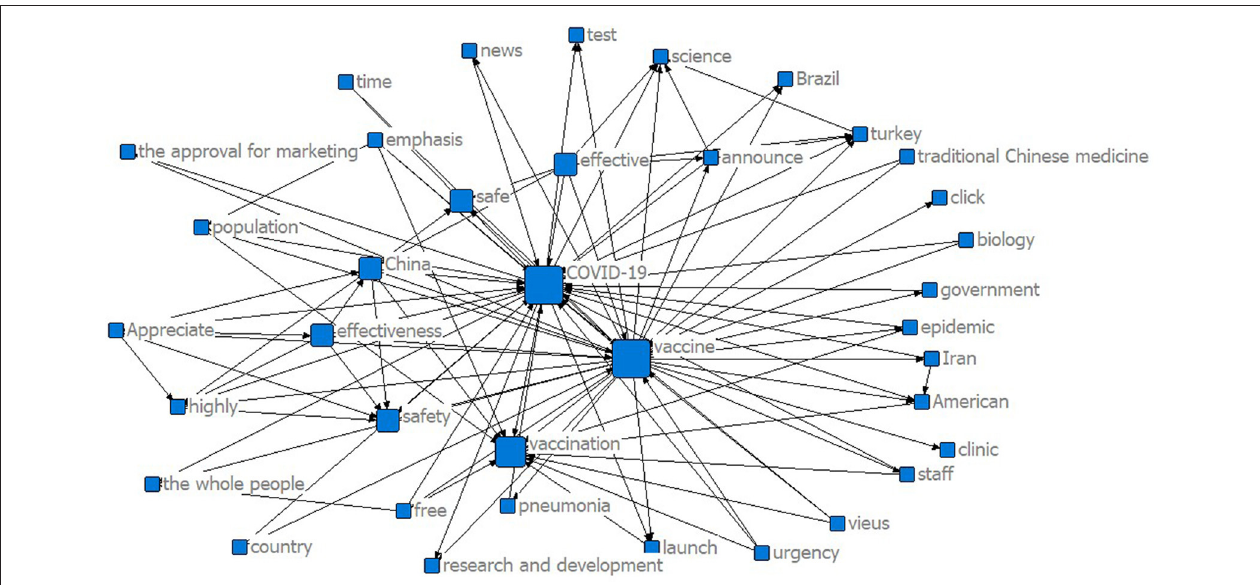
FIGURE 2 | Semantic network graph of domestic COVID-19 vaccines before approved for